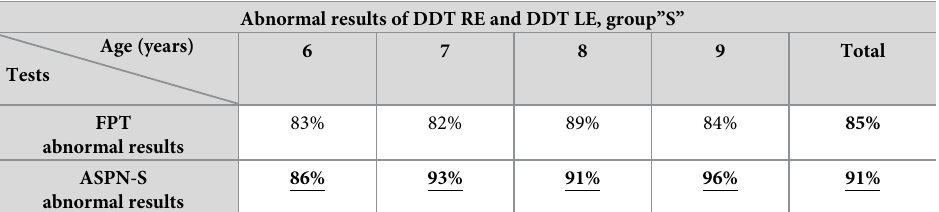
Table 6. Percentage of abnormal FPT and ASPN-S results with abnormal DDT RE and LE results, in group”S”, by age.